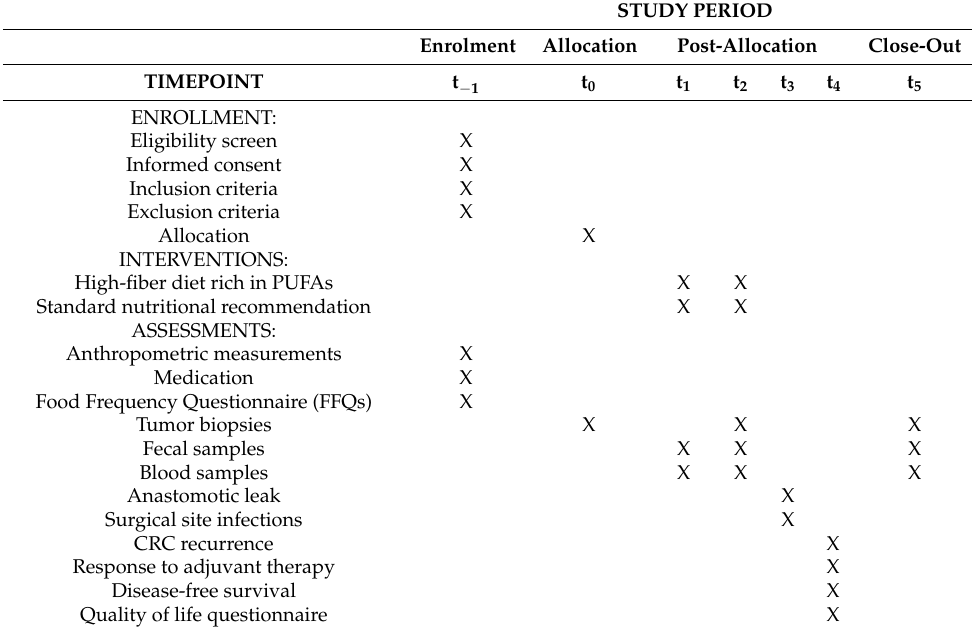
Table 1. Assessment